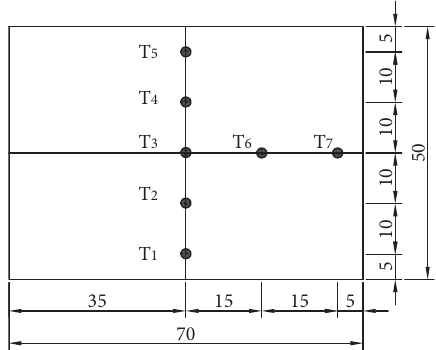
Figure 3: Layout of temperature measurement points